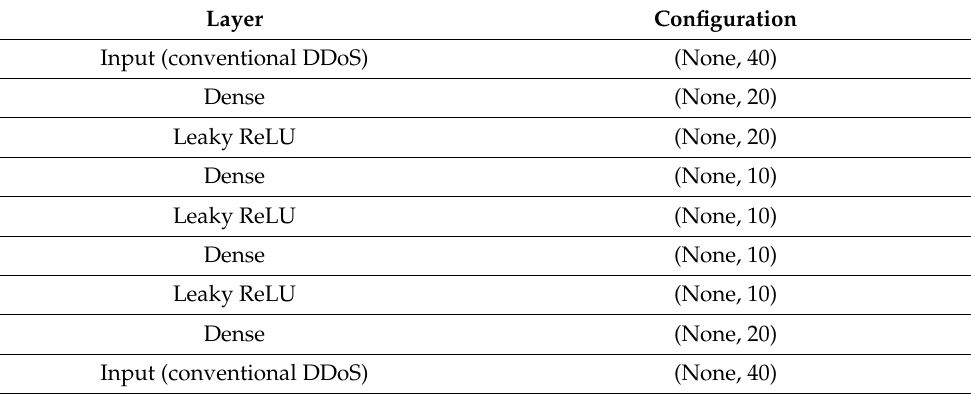
Table 7. Training parameter settings of CycleGAN generating system.